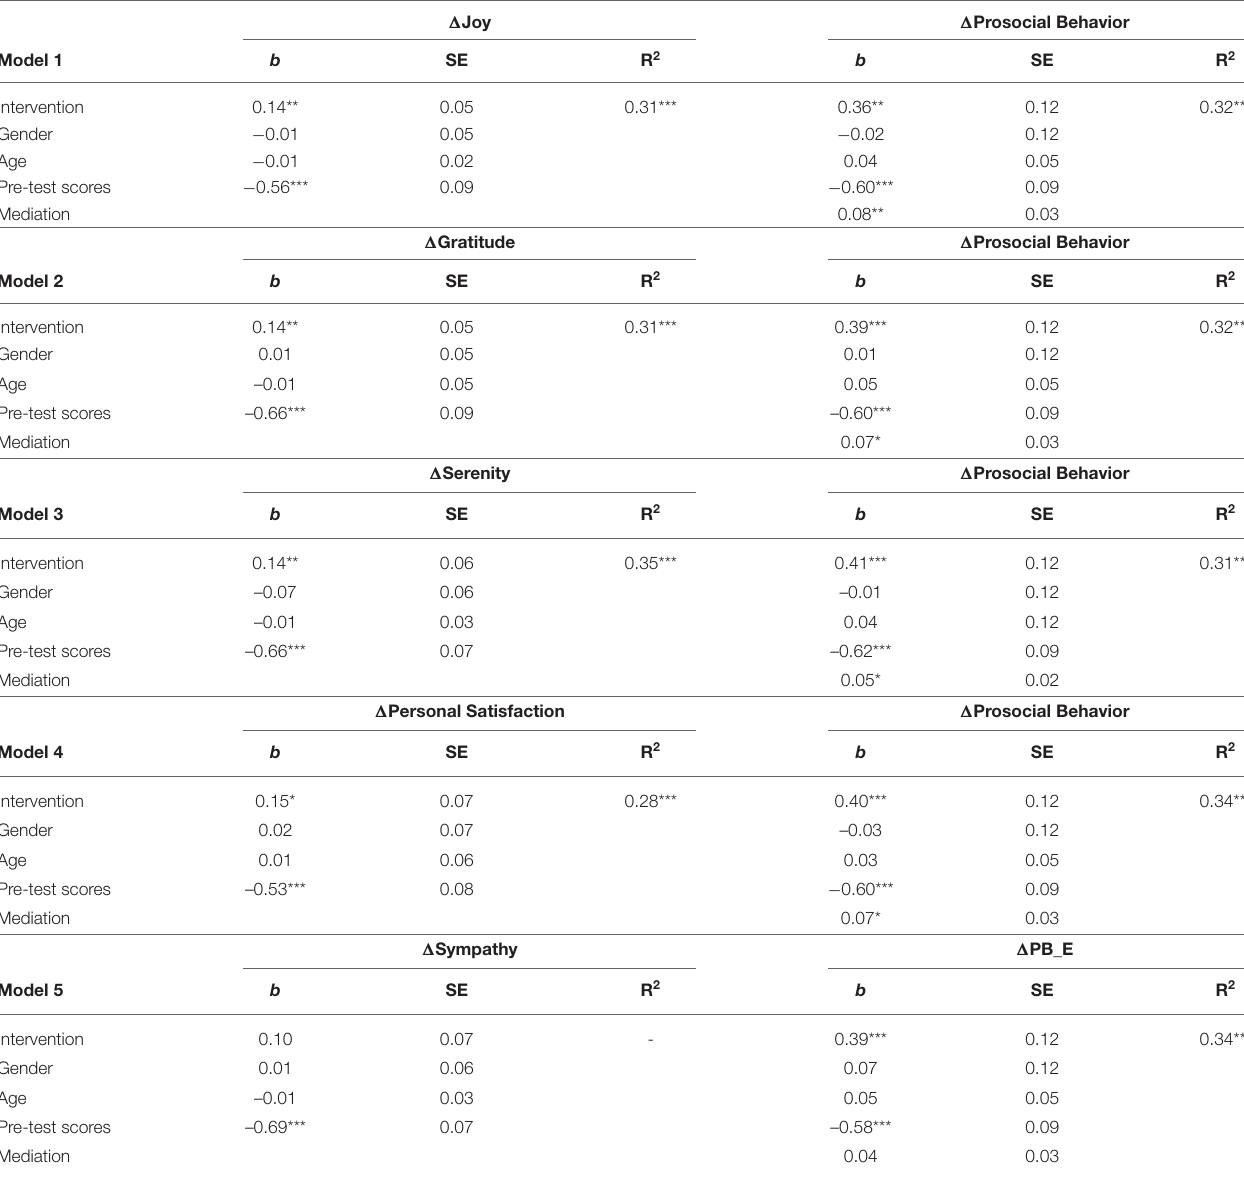
TABLE 2 | Hero Program’s effect on change scores ( 1 ) of positive emotions (joy, gratitude, serenity, personal satisfaction, and sympathy) and prosocial